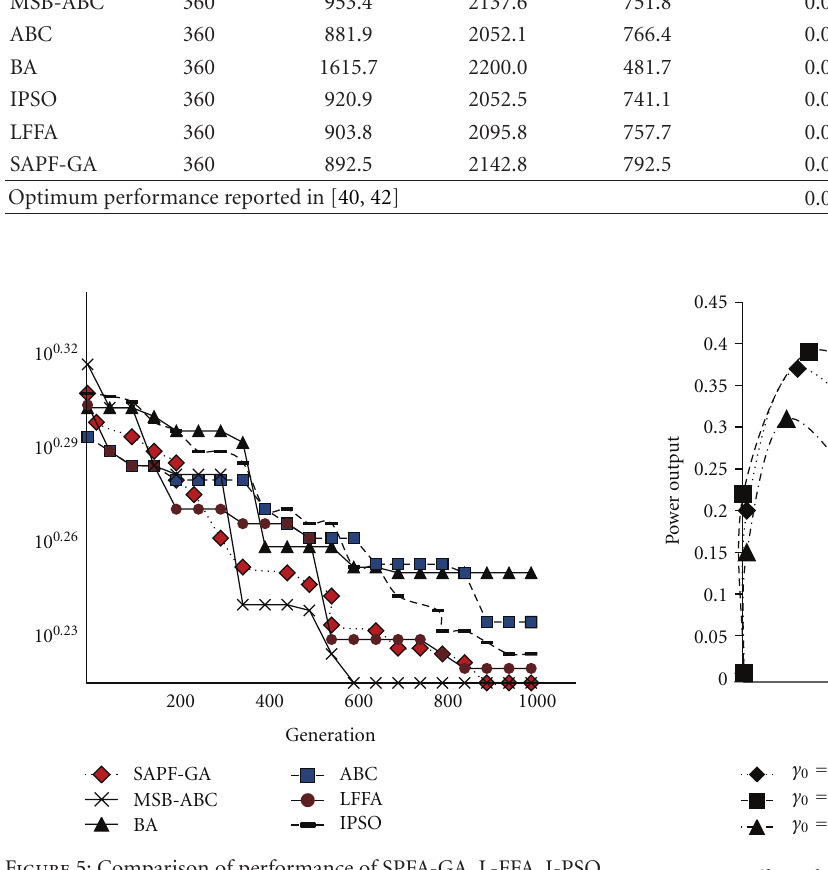
Figure 7: E ff ect of γ 0 on the power output with compression ratio.